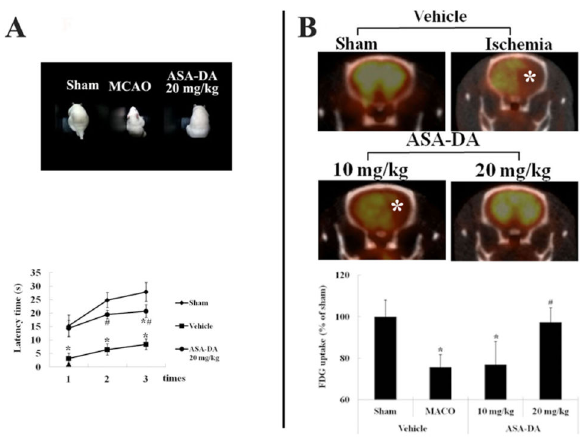
Figure 2. Rotarod test and PET-CT imaging. Rotarod test (A) and PET-CT imaging (B) in the sham-, vehicle-, ASA-DA- pre-ischemia-groups. Only pretreatment with 20 mg/kg ASA- DA significantly ameliorates motor activity and impaired glucose metabolism (asterisks) (n = 7 per group; *P < 0.05, significantly different from the sham-group, #P < 0.05, significantly different from the vehicle-ischemia-group). The bars indicate the means ± SD.